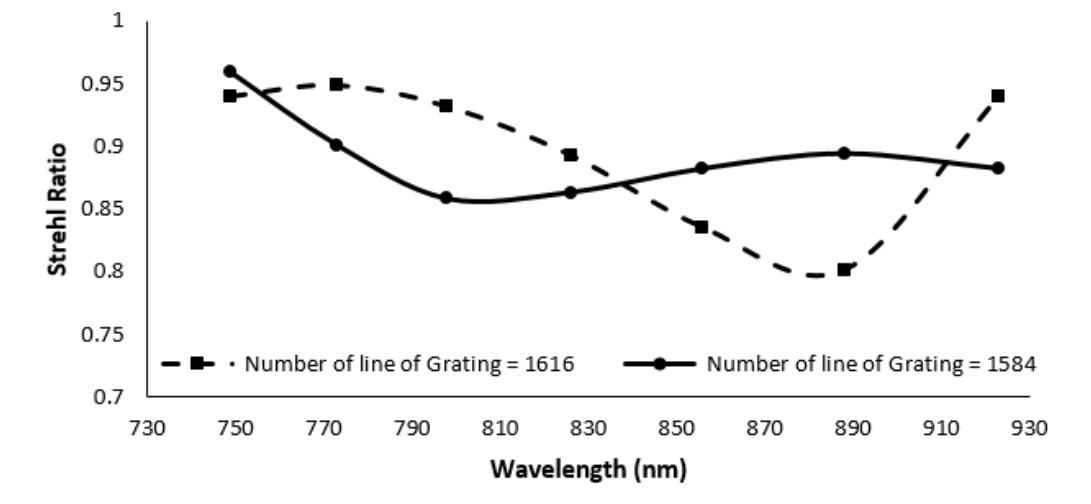
Figure 13. Strehl ratio of the proposed spectrometer for variation of number of lines of grating.